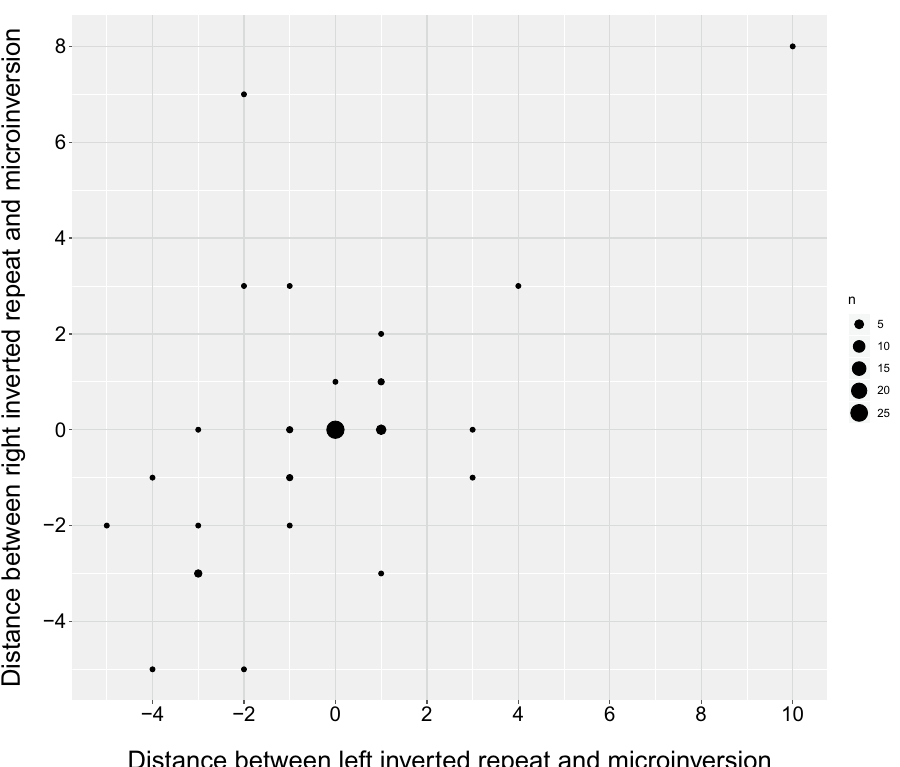
Figure 3. Positions of flanking inverted repeats are correlated with the outer boundaries of microinversions. The x-axis shows the distances in nucleotides between microinversions and inverted repeats on their left; the y-axis shows the distances between microinversions and inverted repeats on their right. Zero value for the left or right repeat means that a repeat is located immediately adjacent to the microinversion; positive value shows that there is a distance between a repeat and the microinversion; negative value shows that a repeat partly overlaps with the